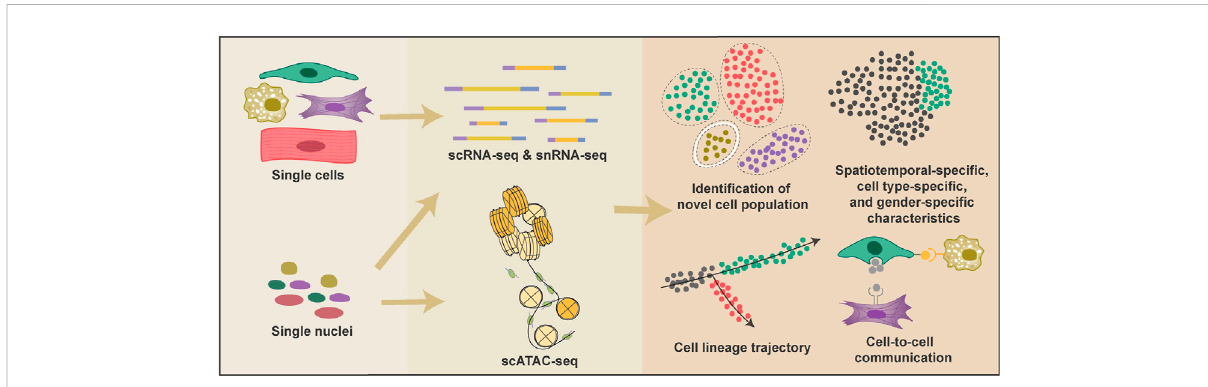
FIGURE 1 Applicationsofsingle-celltechnologiesandanalysesinheartresearch.Single-celltechnologieshavemanyadvantagesoverconventionalbulk- basedgenequanti fi cationmethods.Bothcellsandnucleicanbeusedtogeneratesingle-celltranscriptionalinformation,andnucleiarealsoadopted in scATAC-seq to provide epigenetic information. Single-cell technologies provide information to classify cell types and proportions under various conditions; reconstruct cell fate change trajectories during heart development and diseases; reveal the spatiotemporal-speci fi c, cell-type speci fi c, and gender-speci fi c characteristics of cardiac cells; detect potential cell-cell